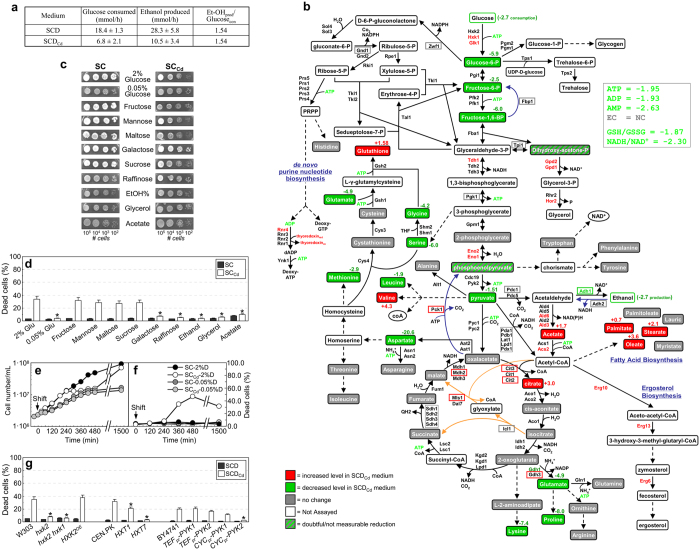
The effects of calcium shortage are carbon source-dependent.(a) Glucose consumption and ethanol production rates were determined in cells grown overnight in either SCD or SCDCd media and resuspended in medium containing 50 mM glucose at a final density of about 4*106 cells/mL. A glucose-to-ethanol ratio close to 2 moles of ethanol produced per moles of glucose consumed (the maximum theoretical value) indicates a mostly fermentative metabolism. Values are means ± SDs of three biological replicates. (b) Alterations in the proteomic and metabolomic profiles of cells grown under calcium shortage in 2% glucose medium (SCDCd). Changes in protein or mRNA levels were evaluated by 2D-page or qRT-PCR, respectively. Increase/decrease under calcium shortage are red/green colored; grey indicates no significant change. A colored box indicates transcriptional regulation under calcium shortage. Proteins whose expression changes under calcium shortage are colored. Blue lines indicate reactions specific for the gluconeogenic pathway. Orange lines indicate reactions specific for the glyoxylate cycle. (c) Cellular suspensions of CEN.PK2-1C cells were serially diluted and spotted on SC and SCCd media plates supplemented with the indicated carbon sources. (d) Cell viability under calcium shortage during exponential growth in liquid media on the indicated carbon source, as evaluated by cytofluorimetric analysis. Values are means ± SDs of two biological replicates (*p < 0.05, two-tailed t-test). (e,f) Log-phase W303-1A cells cultivated in SCD medium containing 2% (w/v) glucose were shifted in either SC or SCCd media supplemented with 0.05% (w/v) glucose (calorie restriction). Cell density (d) and cell viability (e) are shown. A representative experiment out of three performed is shown. (g) Cell viability under calcium shortage for mutants with reduced hexokinase, sugar uptake and pyruvate kinase activity, as evaluated by cytofluorimetric analysis. Values are means ± SDs of three biological replicates (*p < 0.05, two-tailed t-test).